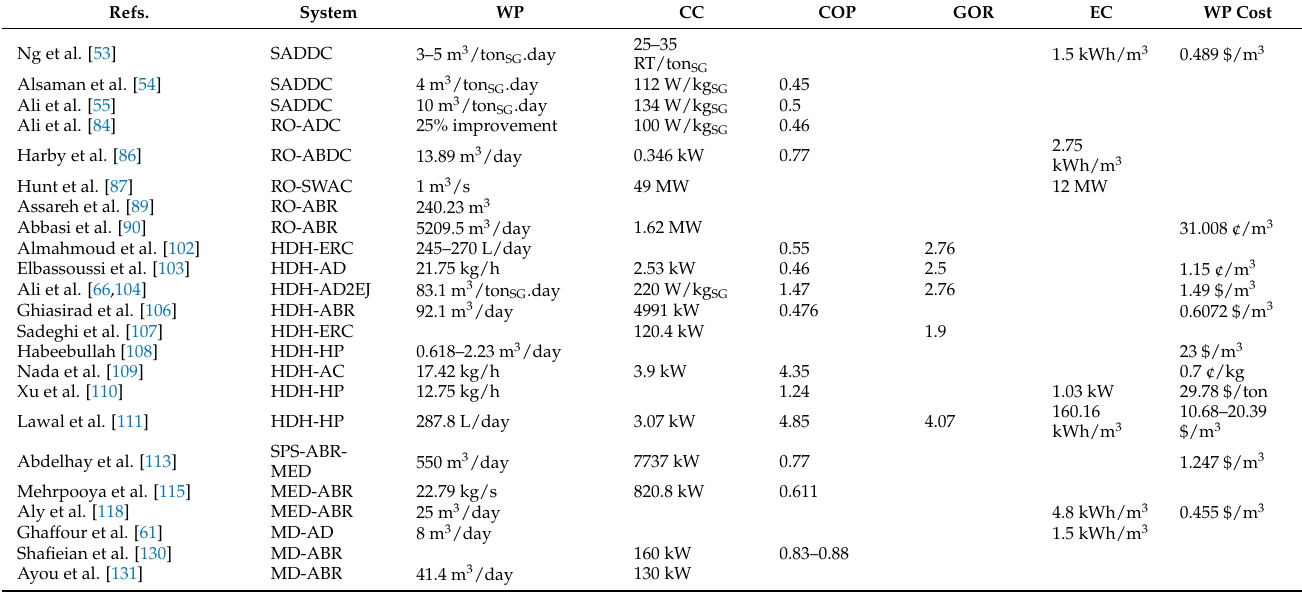
Table 2. Summary of main research covering the performance of hybrid solar desalination/cooling